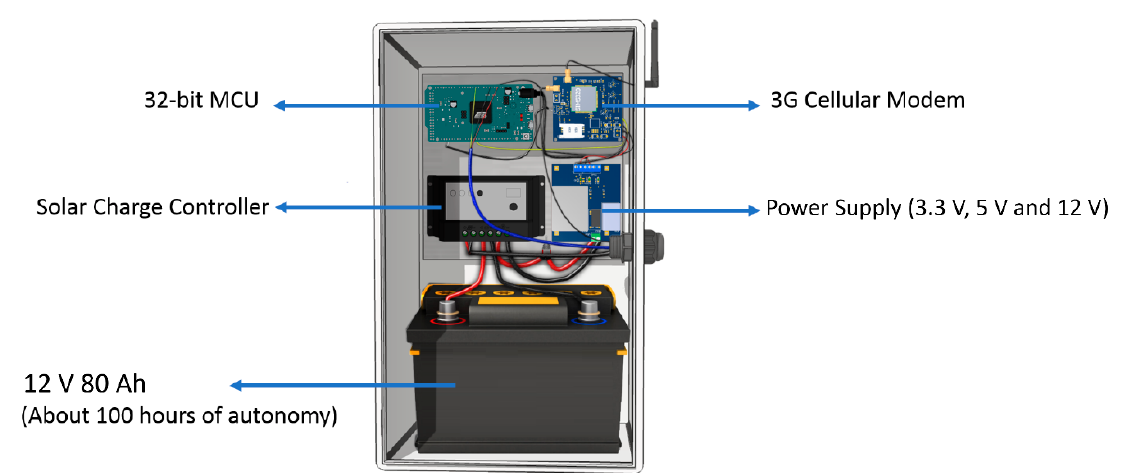
Figure 1. RiverCore fixed node components. Sensors 2018 , 18 , x FOR PEER REVIEW